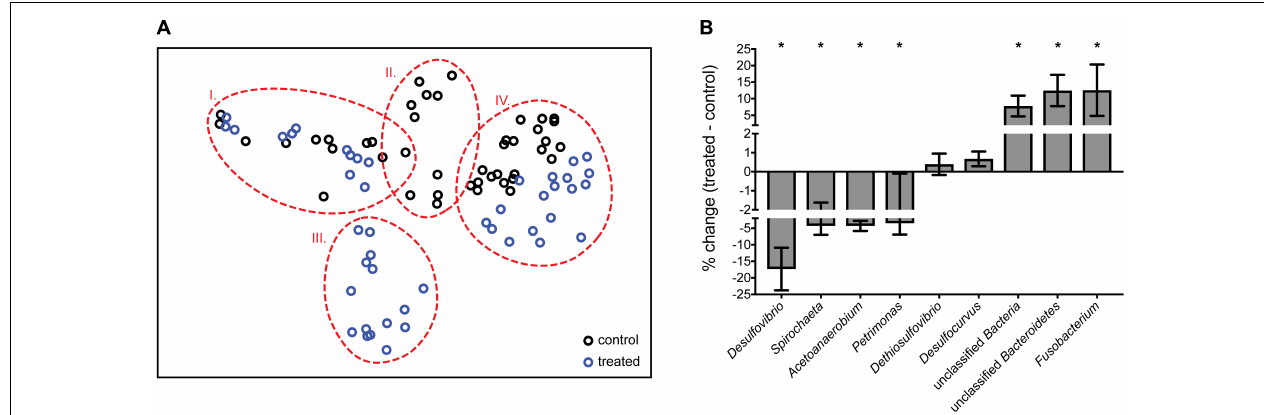
FIGURE 2 | (A) nMDS (non-metric multi-dimensional scaling) plot of normalized and transformed 16S amplicon community profiles for control (black) and treated (blue) communities. Dashed red lines group samples at 70% similarity. Stress value of 0.1. Group I: pre-treatment; groups II and III: treatment; group IV: post-treatment (B) % change between control and treated samples during treatment ( A , group II vs. III) of genera identified as important by SIMPER analysis. Error bars represent SD. ∗ Genera which differ significantly via ANOVA ( p < 0.001) between control and treated communities.